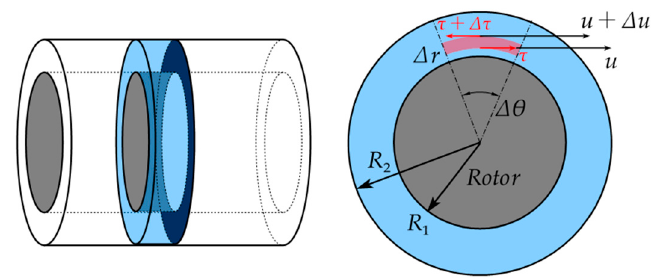
Figure 1. Schematic diagram of the velocity and force of fluid micro-element in the air gap.